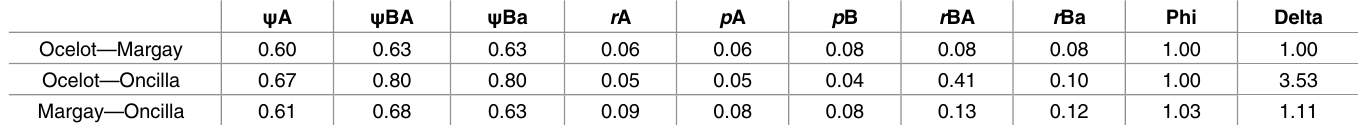
Table 3. Occupancy ( ψ ), detection probability ( p and r ), and species interaction factor (SIF—phi and delta) estimated from co-occurrence occu- pancy models of three sympatricNeotropical spotted cats in a large Atlantic Forest